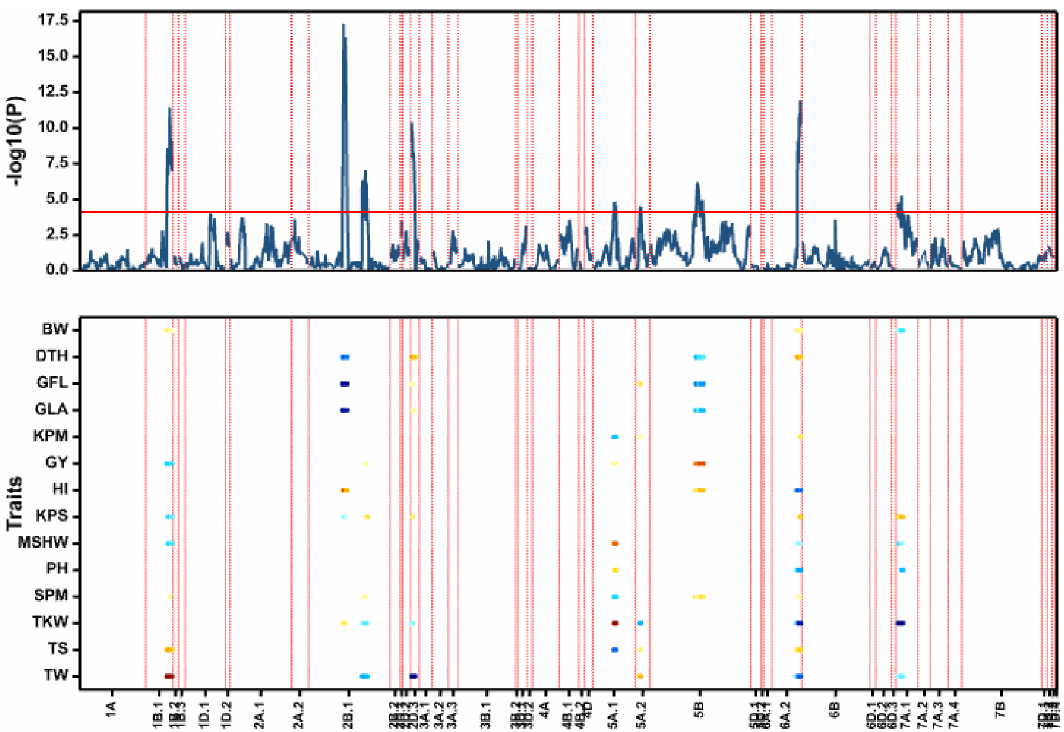
Fig 2. Genomewide scan for multi-trait QTL for grain yield and agronomic traits. The upper graph is the QTL profile plot with the y-axis representingthe log of likelihood,-log (P), for declaring significanceof QTL. The red horizontal line representsthe thresholdcorrected for the numberof independenttests using Li and Ji [38]. The lower profile is the genomewideheat map of significantQTL across environments. The y -axis is the traits and the x -axis representsthe chromosomes. The light blue to blue color indicatesthe high value alleleoriginatesfrom CO9602932 and the yellow-red color indicatesthe high value alleleoriginatesfrom TAM 111.